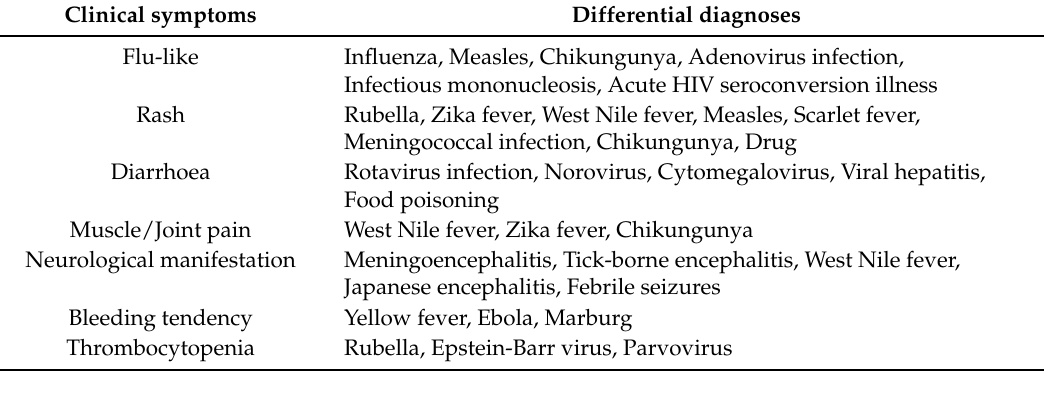
Table 1. Differential diagnosis for dengue illness.